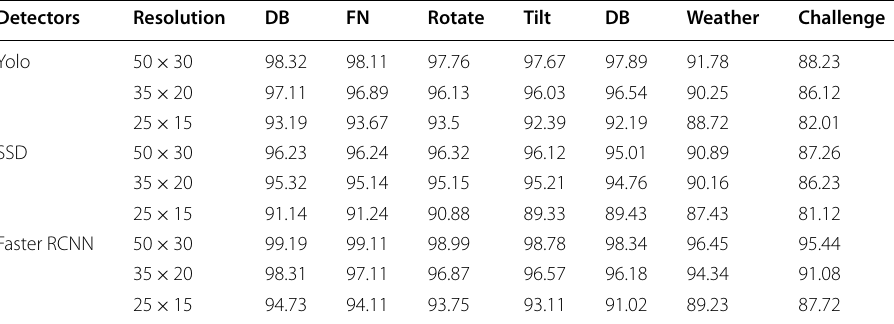
Table 10 Performance comparison of state-of–the-art detectors on decreasing LP size